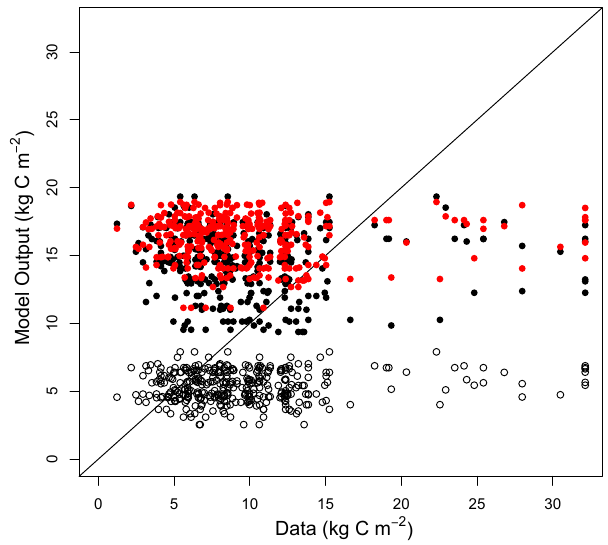
Fig. 1. Scatterplot of the C stock in 1980 calculated by ORCHIDEE- AR5 (black circles), ORCHIDEE-AR5-PRIM (red circles) and O- CN (open circles) versus the observed C